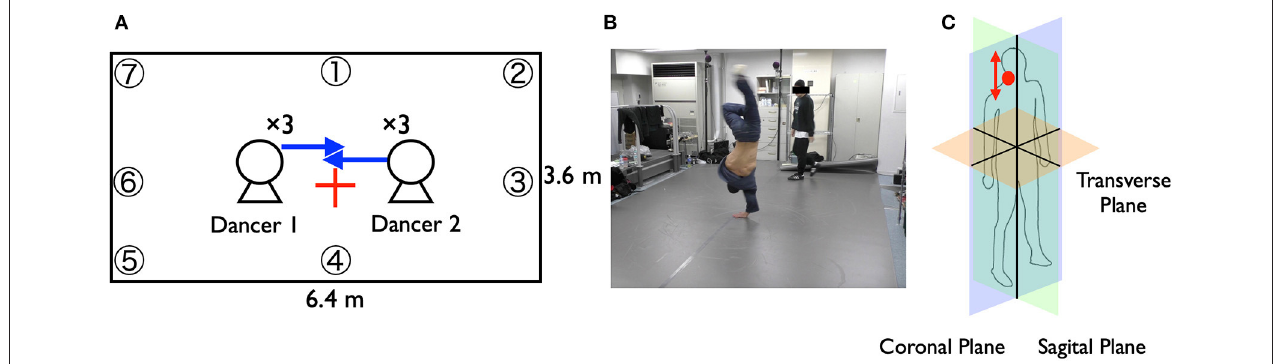
FIGURE 1 | (A) Outline of the battle scene. Two dancers faced each other and showed their performances in turn. (B) Picture of the battle scene. One dancer showed his performance, and another dancer watched and responded to his performance. (C) Body plane. The red circle indicates the marker position, and the red arrow indicates the movement direction we